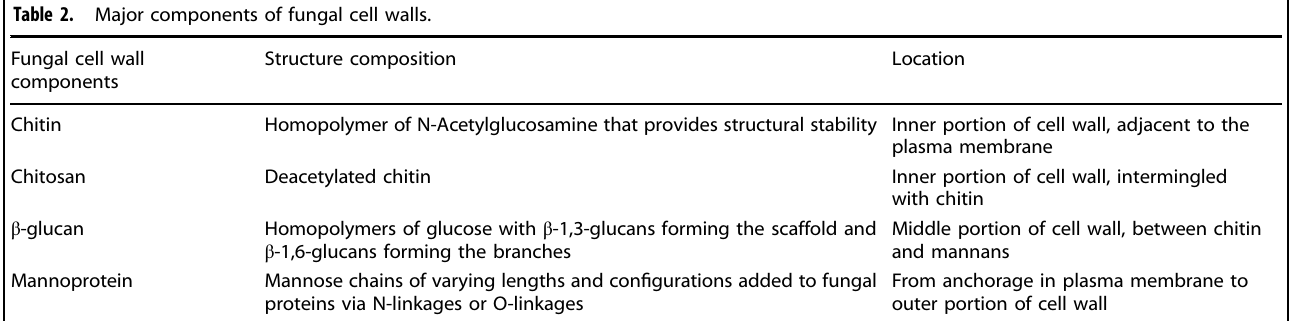
Table 2. Major components of fungal cell